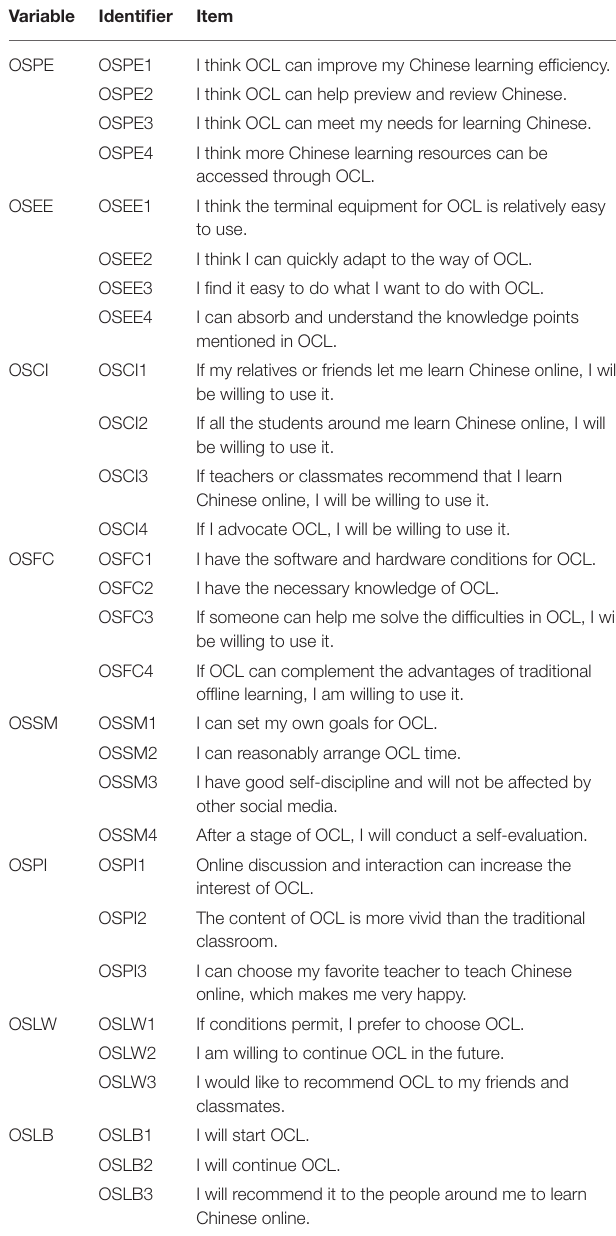
TABLE 2 | Measurement items of